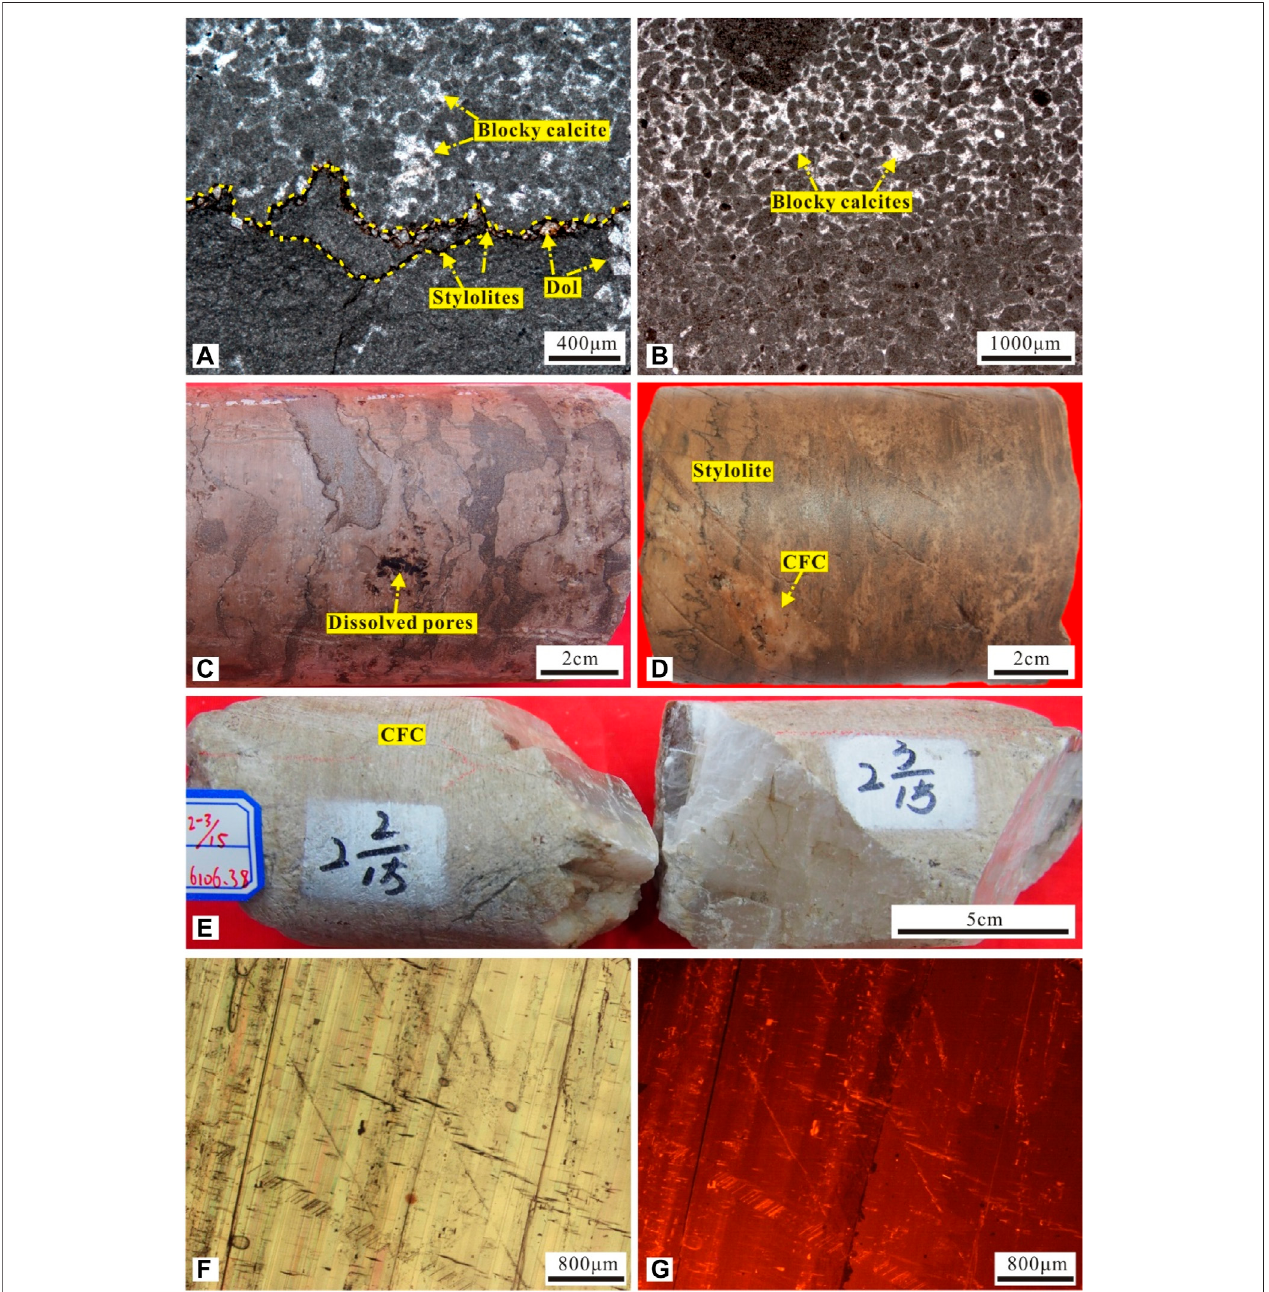
FIGURE 4 | Petrological characteristics of the matrix limestone and CFC. (A) Bedding-parallel stylolite represents at lithological transitional interface between lime- wackstone and lime-mudstone; subhedral dolomite scattered along the stylolites, together with residual bitumen, TS3, 6,239.05 m, O 1-2 y . (B) Photograph of lime- wackstone and lime-packstone. The intergranular pores were completely fi lledby calcite cements,TS3-1, 6,239.62 m, O 1-2 y . (C) Dissolved pores arepartially fi lled with bitumen, TS3-1, 6,237.45 – 6,237.57 m, O 1-2 y . (D) The fracture and related karstic reservoirs fi lled with CFC crosscut the stylolites, TS4, 6,133.0 – 6,133.12 m, O